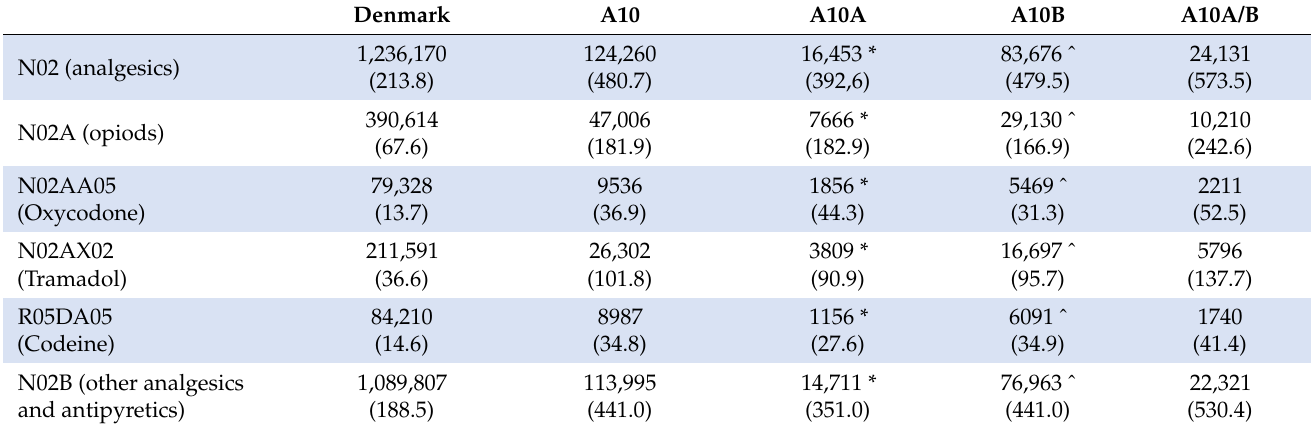
Table 3. Number of users and prevalence of analgesics, psycholeptics, and